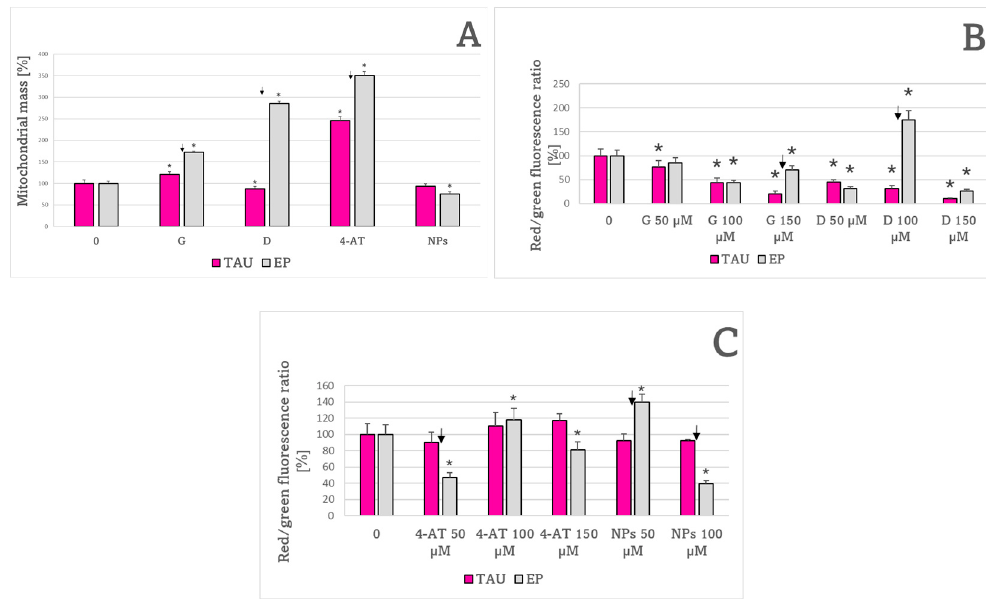
Figure 12. Effect of antioxidants (50 μ M) on mitochondrial mass ( A ) and concentration dependence of the effects of antioxidants on the JC-1 red to green fluorescence ratio ( B , C ) after 24 h as a measure of the mitochondrial membrane potential in TAU and EP cells. Values of the mitochondrial mass and JC-1 fluorescence ratio are expressed as percent of values in cells of respective lines not subjected to any treatment (“0”). G, genistein; D, delphinidin. * p < 0.05, compared to cells not treated with the antioxidant; ↓ p < 0.05, TAU cells compared to EP cells treated with the same concentration of the antioxidant; n = 3.